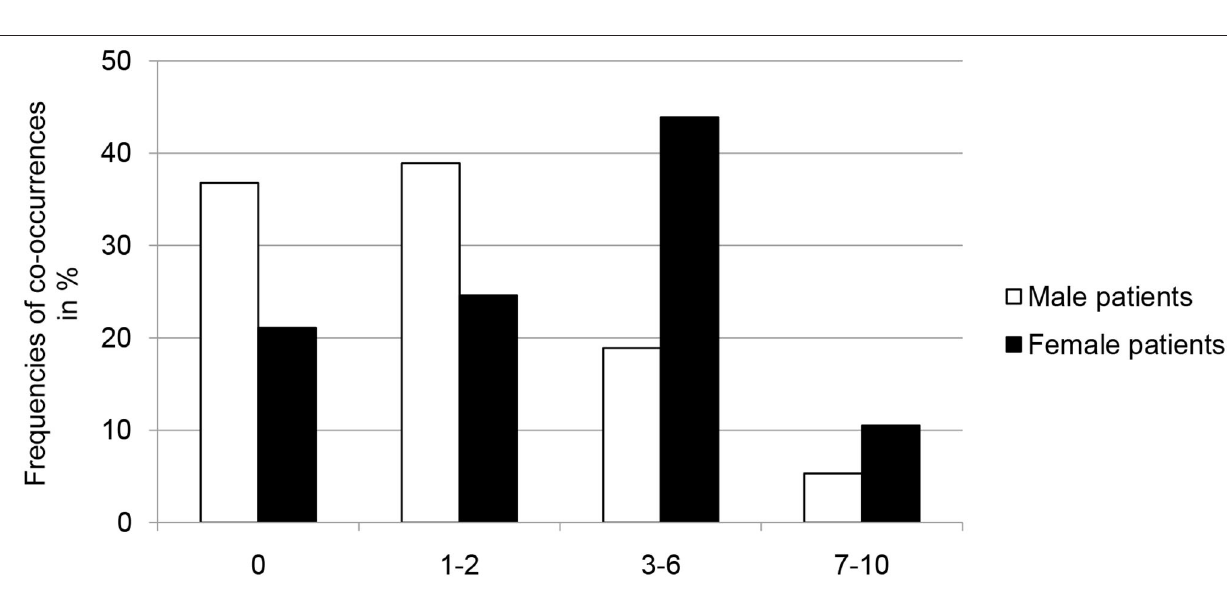
FIGURE 3 | Frequencies (in percent) of co-occurrences of adverse childhood experiences in male ( n = 115) and female ( n = 61) forensic psychiatric inpatients with substance use